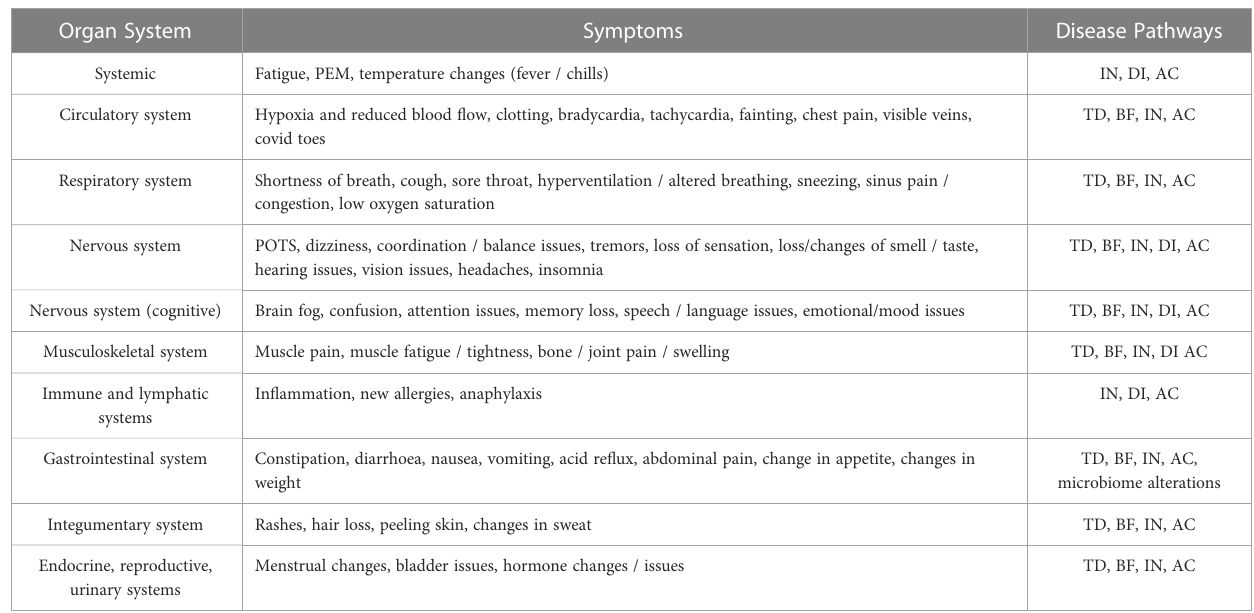
TABLE 1 PASC symptoms and proposed disease